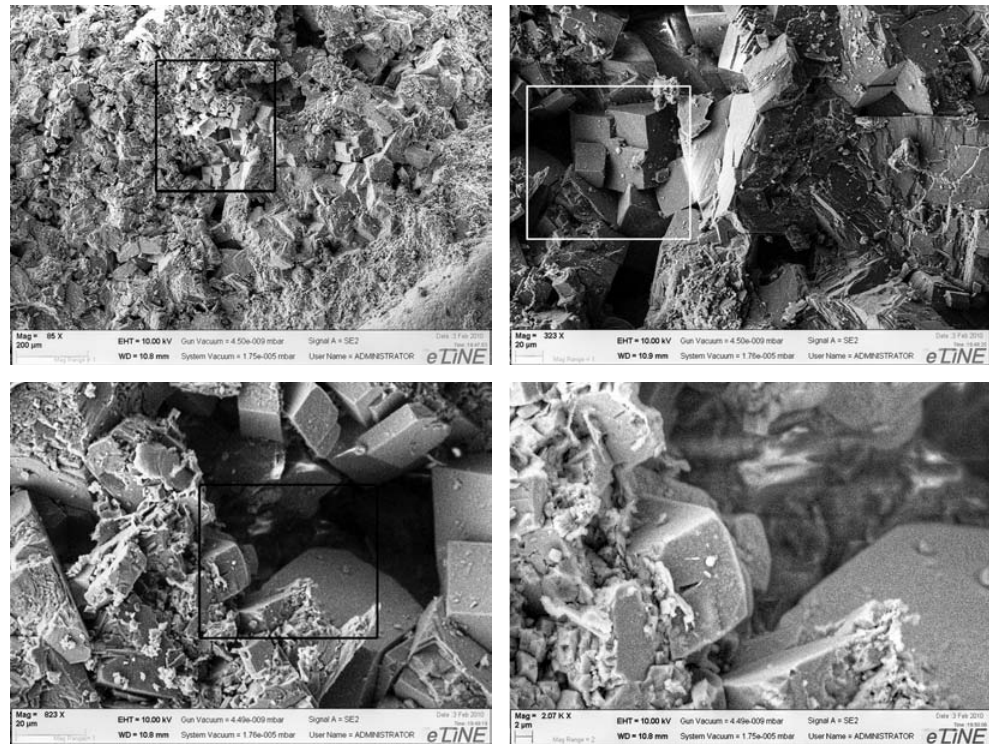
Fig. 11 . The structure of D3 series concrete